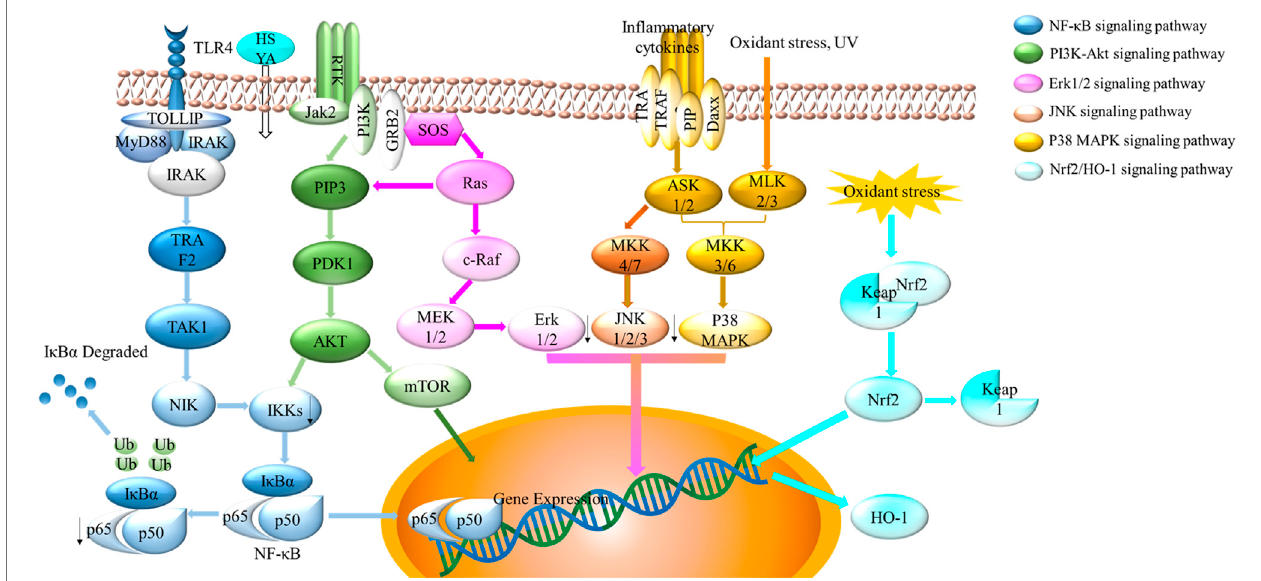
FIGURE 8 | Schematic showing multiple signaling pathways of HSYA. The four crucial signaling pathways were displayed above, including NF- κ B signaling pathway, PI3K-Akt signaling pathway, MAPK signaling pathway (Erk1/2, JNK, p38 signaling pathway), and Nrf2/HO-1 signaling pathway.